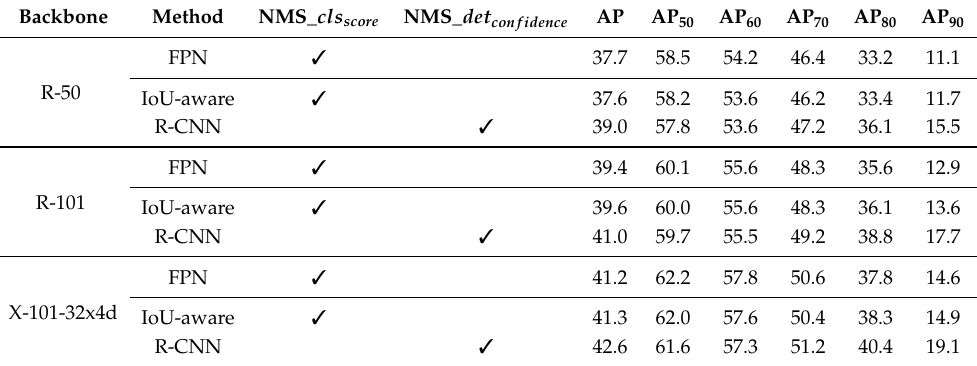
Table 3. Detailed comparison of NMS with different confidences of score cls and det confidence on multiple popular